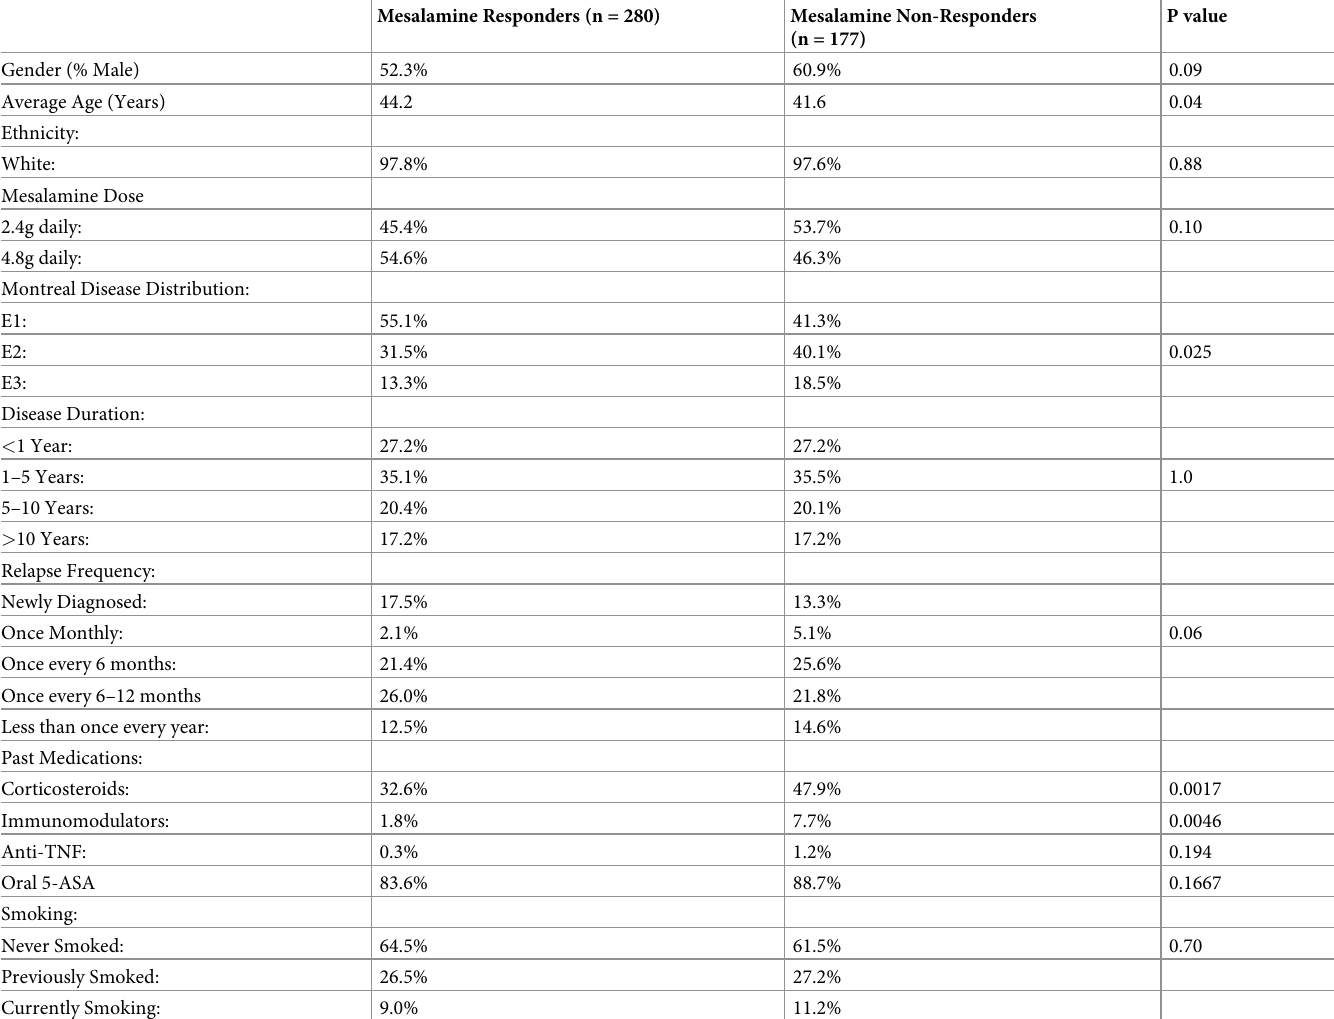
Table 1. Description of cohort under study. Disease distribution was defined by Paris classification system. All comparisons were made by Chi square analysis or stu- dent’s t test.